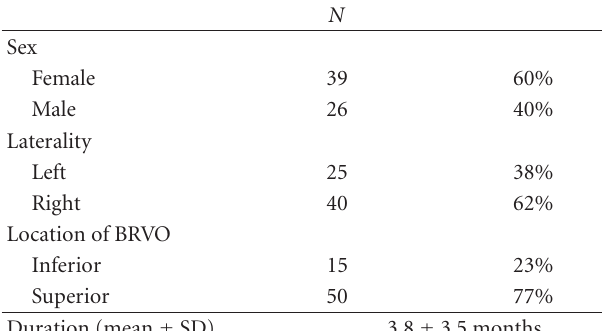
Table 1: Patient